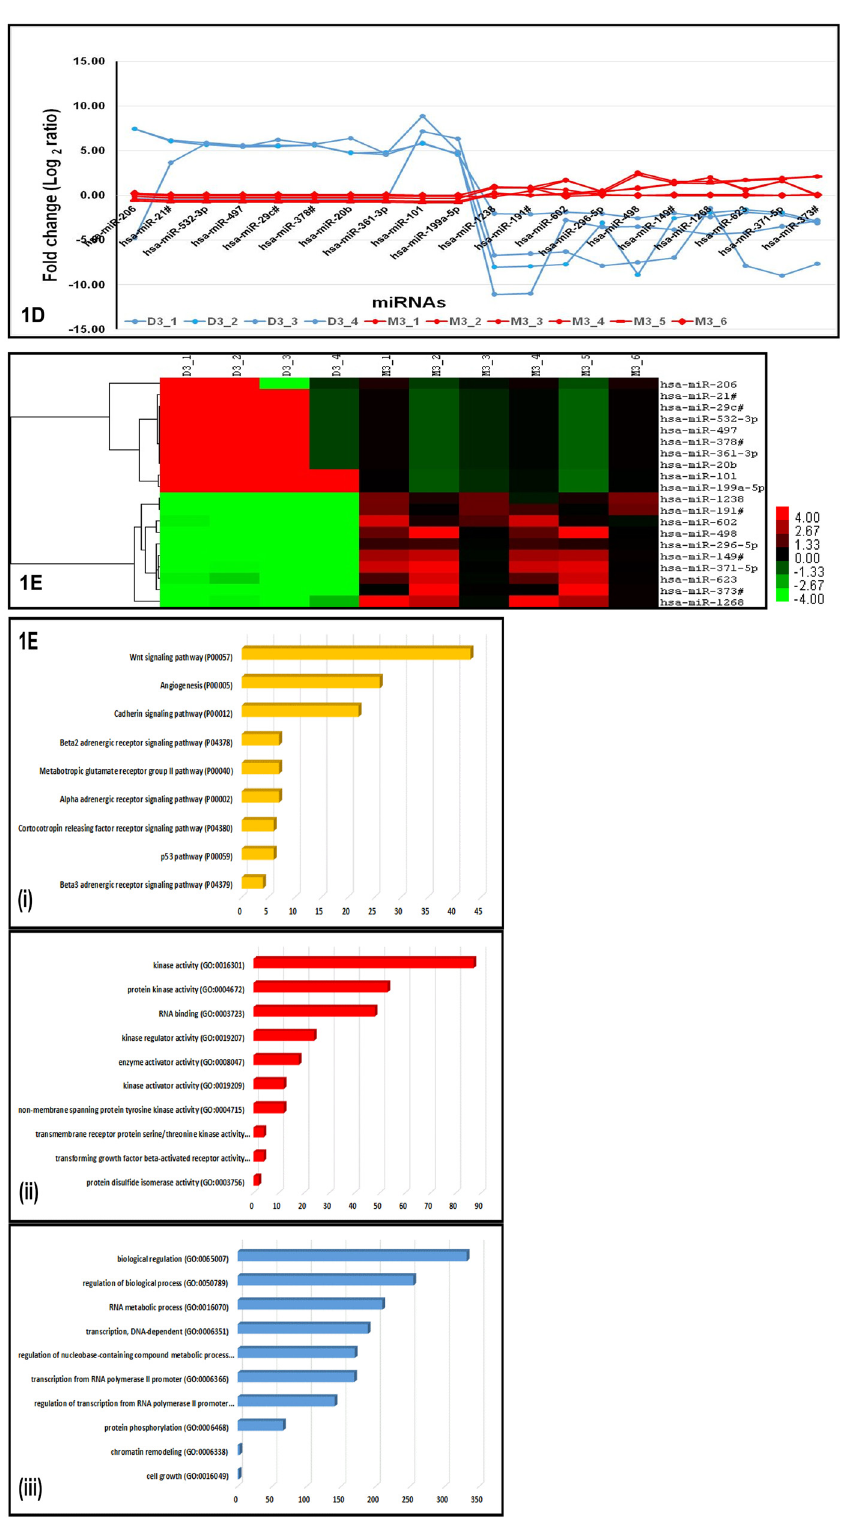
Fig 2. Significantly dys-regulated miRNAs and pathways in UM. A: Trendline graph shows the absolute expression of key miRNAs identified by ANOVA and SAM. The differentially expressed miRNAs indicates the discriminating profiles in M3 and D3 UM tumors. The blue line indicates the miRNA expression in D3